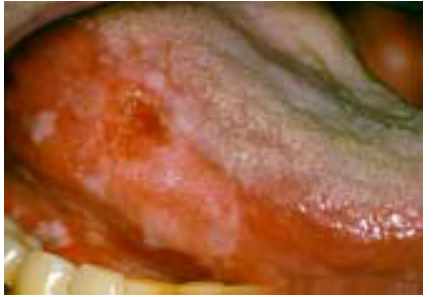
Fig. 3. DNA-histogram of a smear from a squamous cell carcinoma of the tongue (patient A). Different aspects of DNA-aneuploidy can be detected: abnormal stemline 4.31c and 7 cells greater 9c